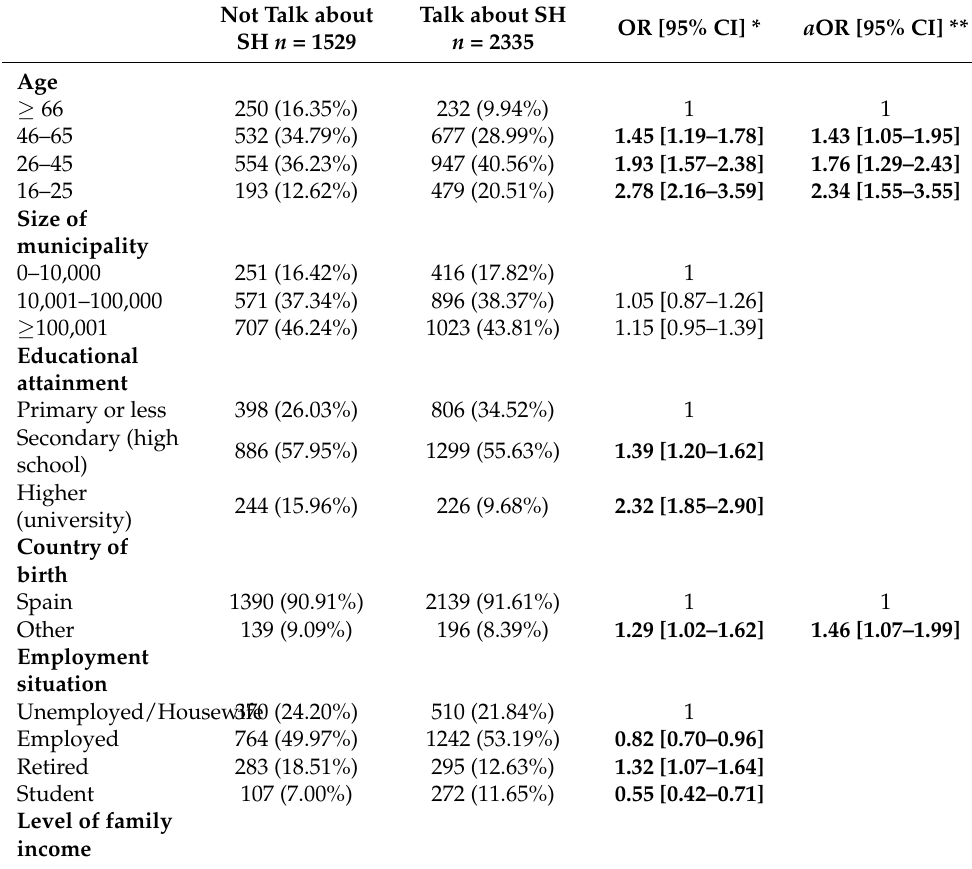
Table 5. Characteristics of women who do not talk about